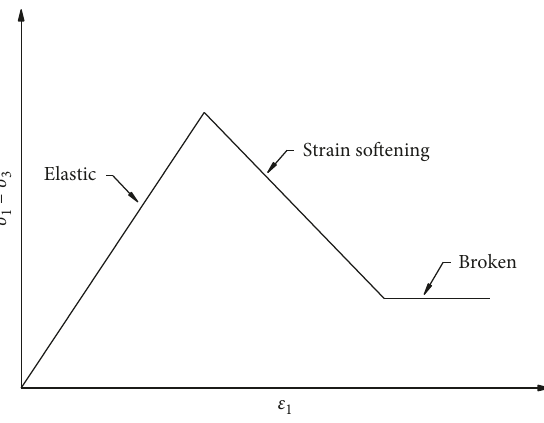
Figure 3: Elastic strain-softening model of the rock.